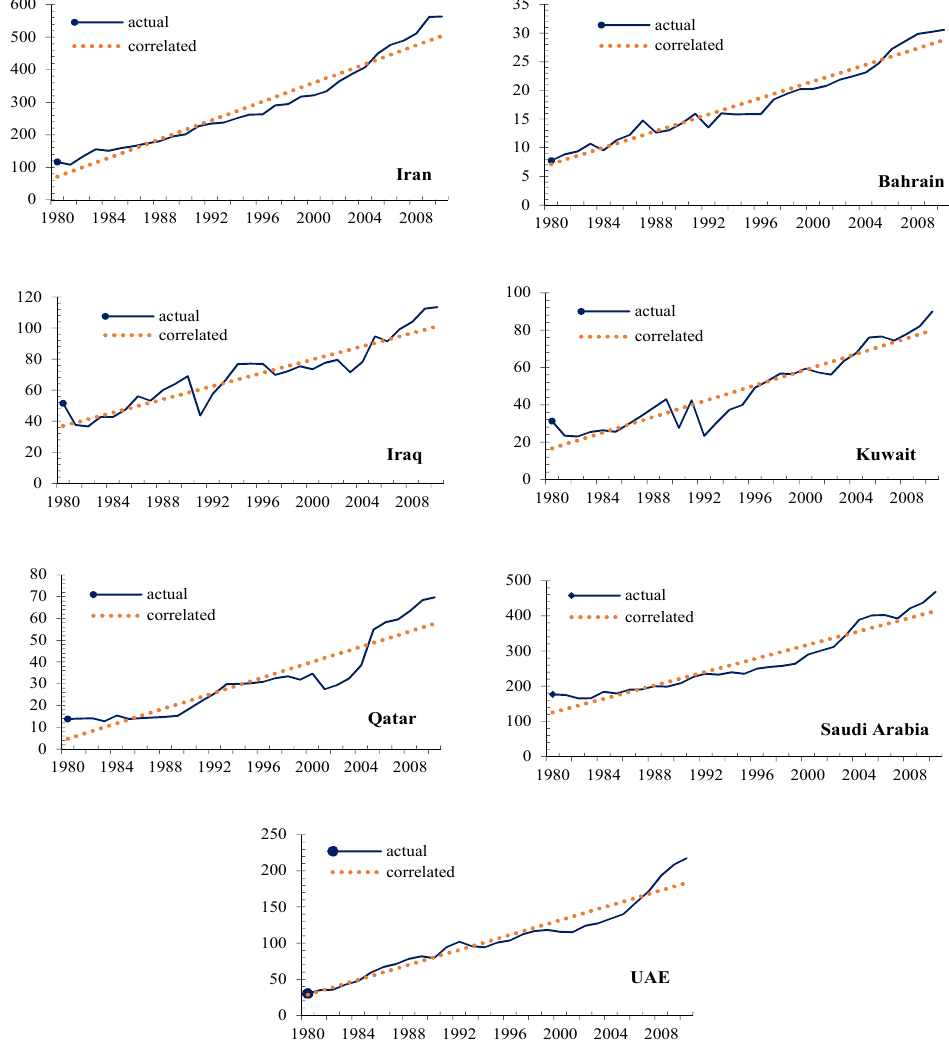
Fig. 3: Persian Gulf Countries actual and correlated CO emissions during 1980-2008 2 (The vertical axis unit is CO emissions in Mtonnes and the horizontal axis is in 2